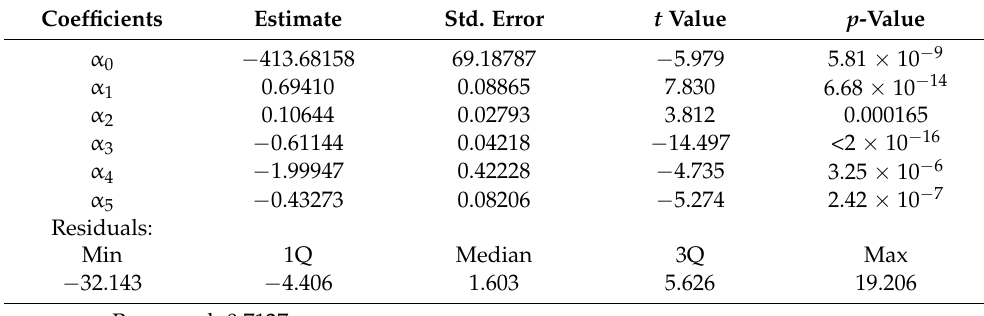
Table 3. The table contains the summary of the model described in Equation (3), adjusted to the training dataset.